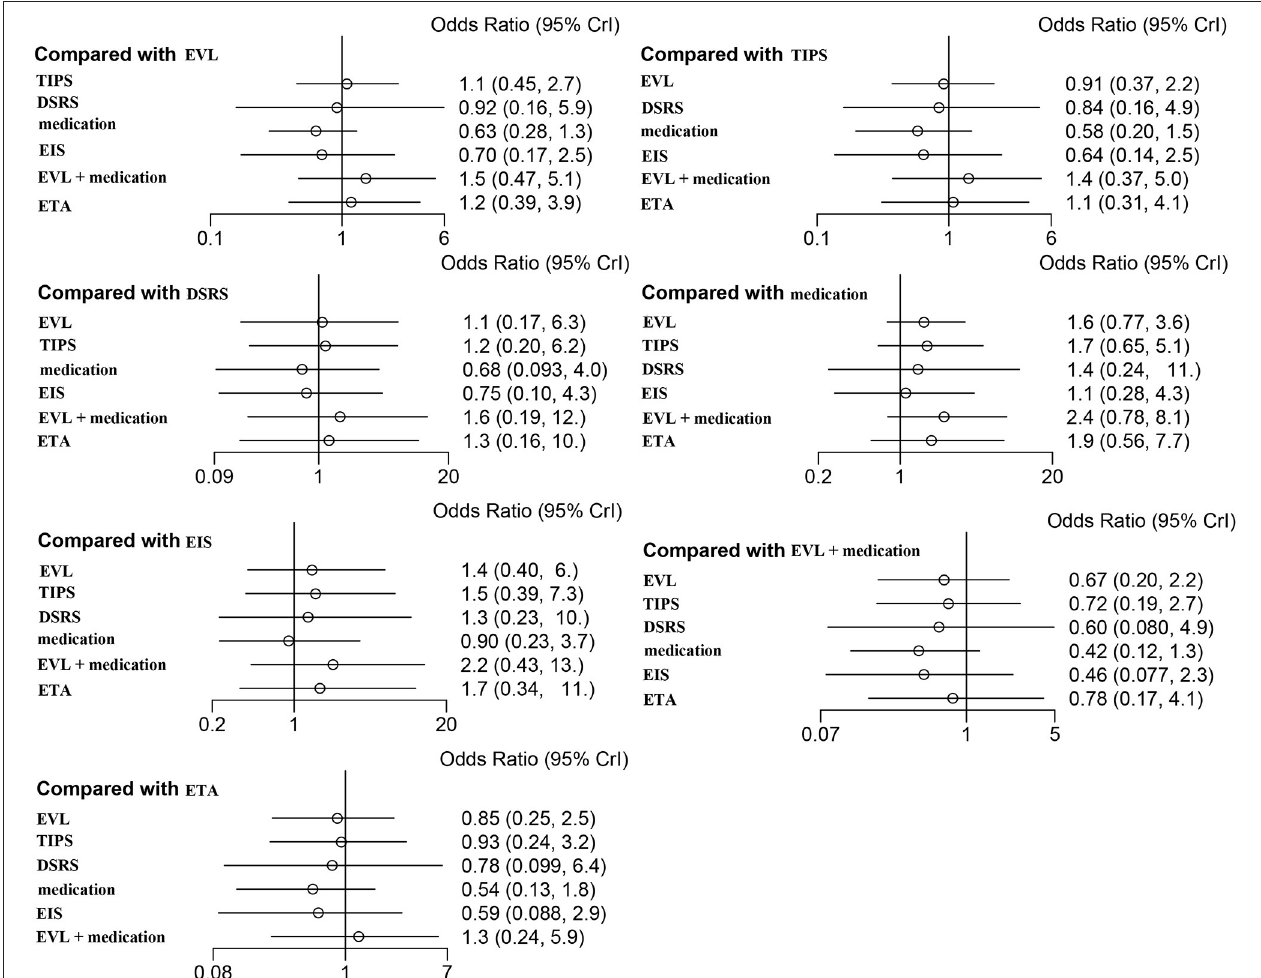
FIGURE 5 | Forest plot of the odds ratios for 1-year OS based on different pairwise comparisons. EVL, endoscopic variceal ligation; TIPS, transjugular intrahepatic portosystemic shunt; DSRS, distal splenorenal shunt; EIS, endoscopic injection sclerotherapy; ETA, endoscopic